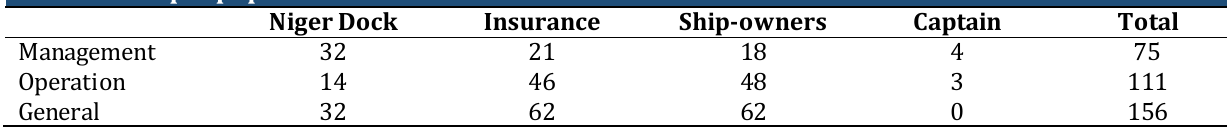
Table 2: Sample population